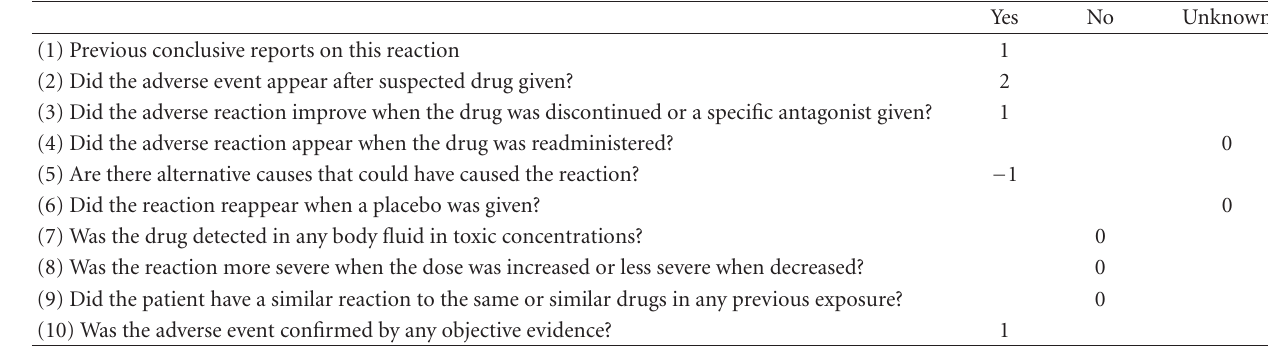
Table 2: Naranjo score for the likelihood of an adverse drug